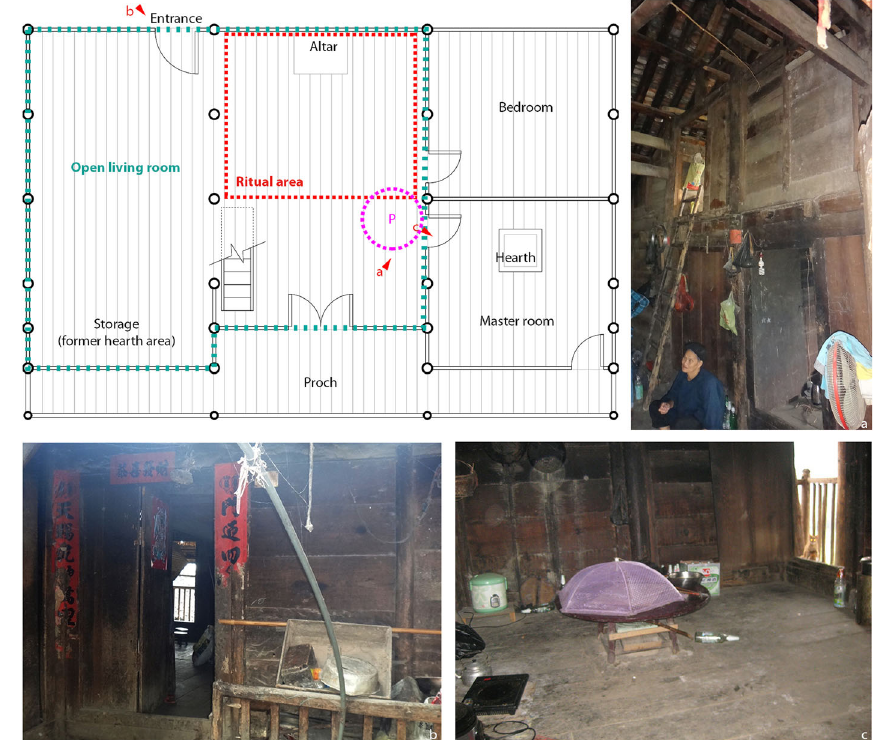
Fig. 12 The floor plan and photos of S5 show a sequence from the entrance (photo b) via the P area (photo a) to the master bedroom (photo c), which is similar to type A. The symmetrical axis from the T-shaped porch to the altar is similar to type B (Source: the